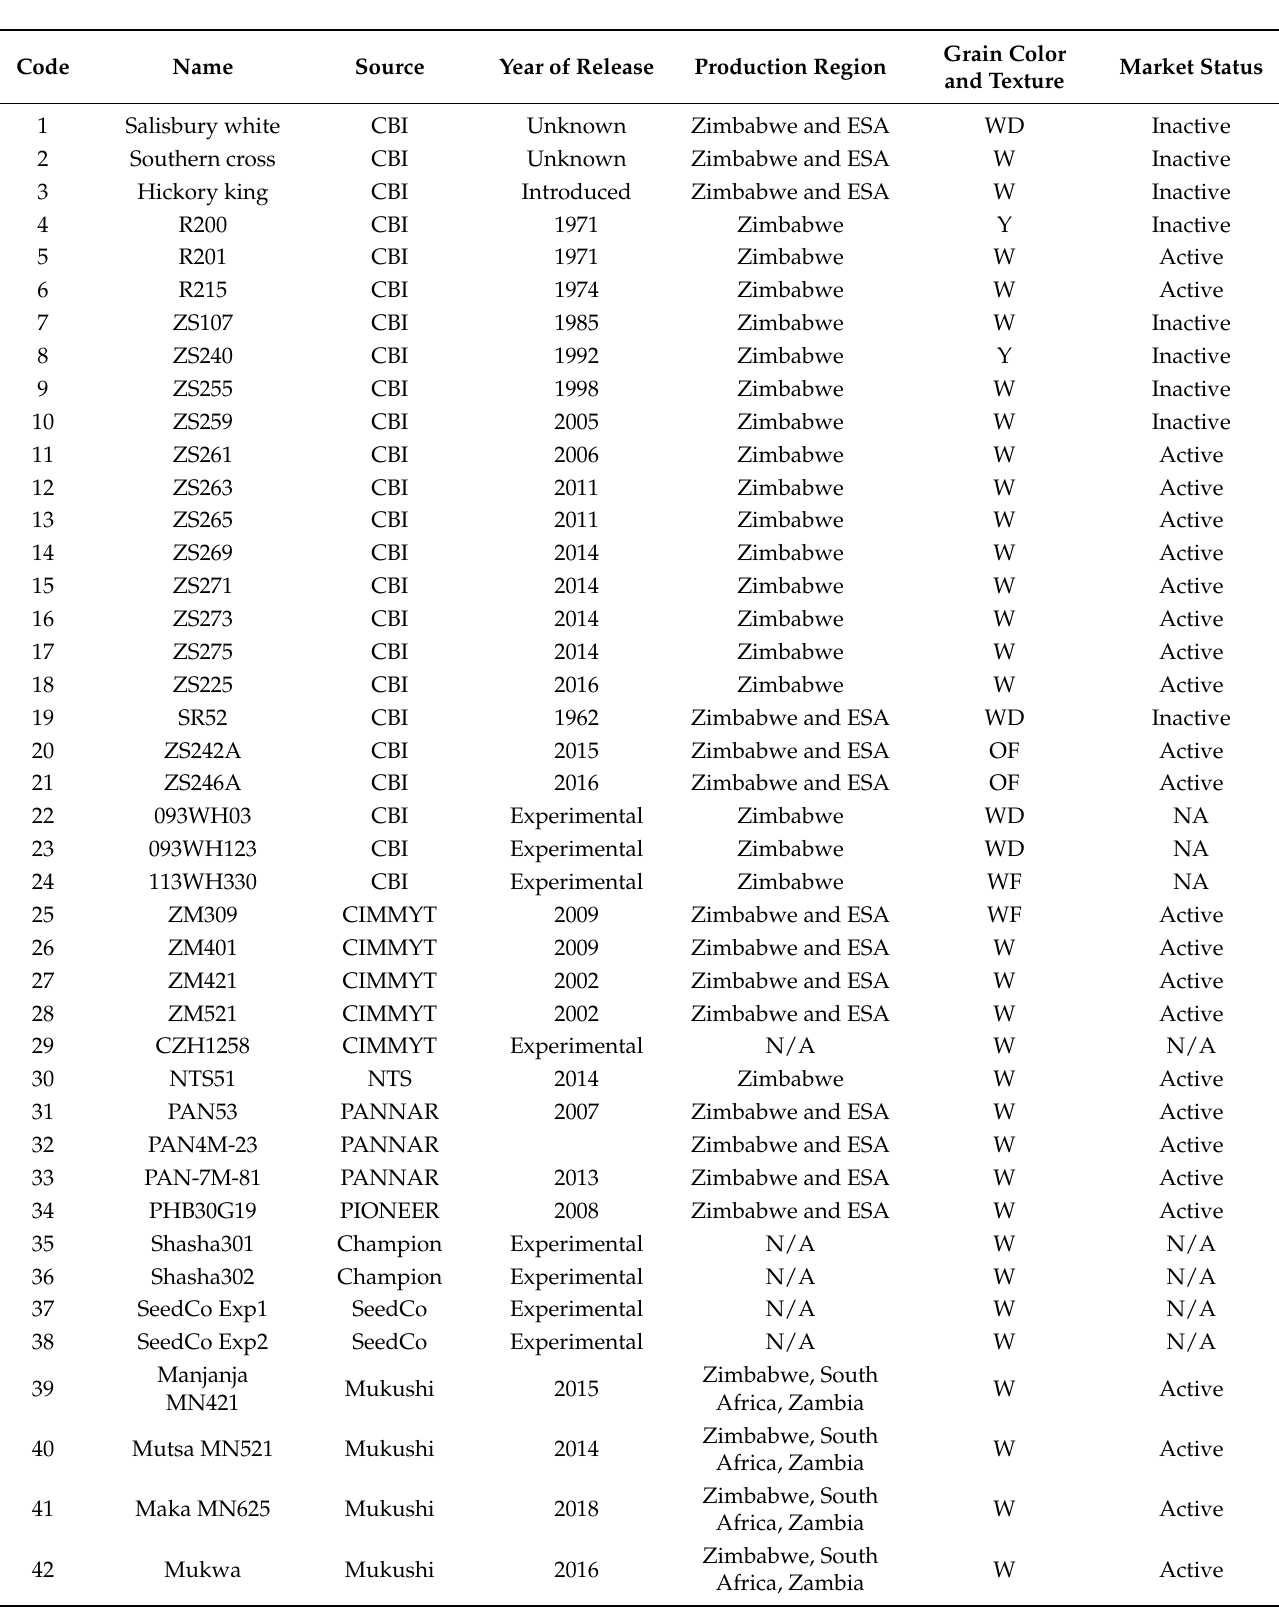
Table 1. Description of commercial cultivars evaluated for tolerance to fall armyworm under natural infestation in